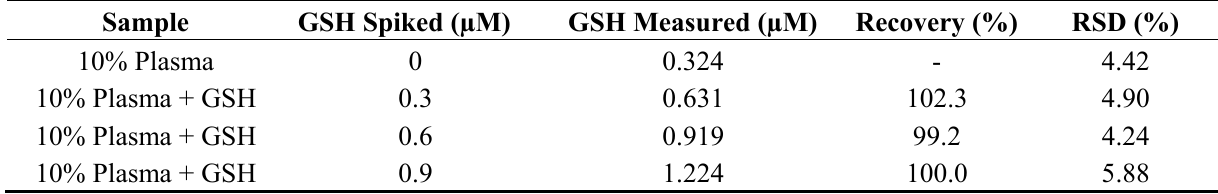
Table 1. Determination of GSH content in 10% deproteinized human plasma samples.